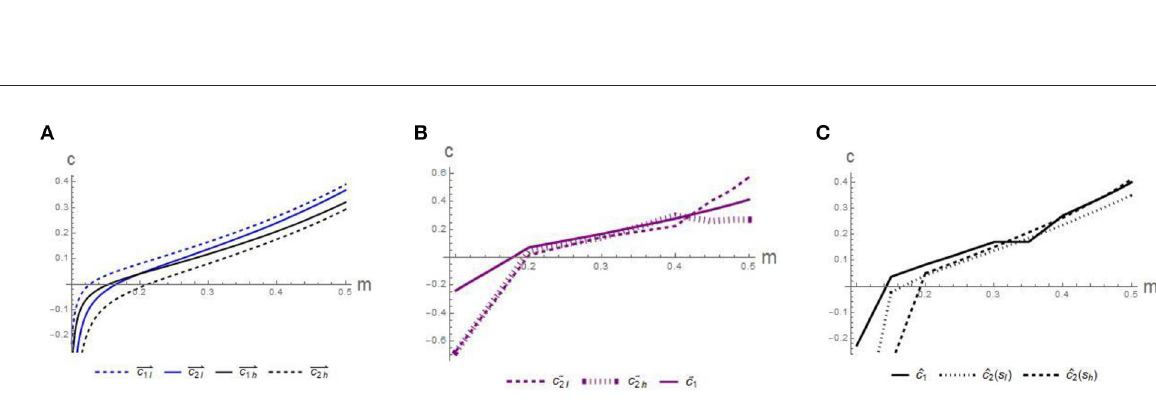
FIGURE3 Impact of initial signing rate on the disclosure intensity c in scenario: (A) separating-separating, (B) pooling-separating, and (C)